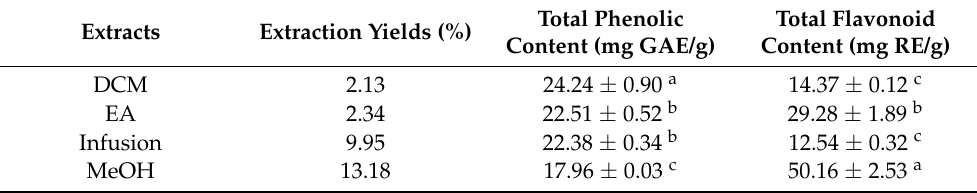
Table 3. Extraction yields and total bioactive components in the tested extracts